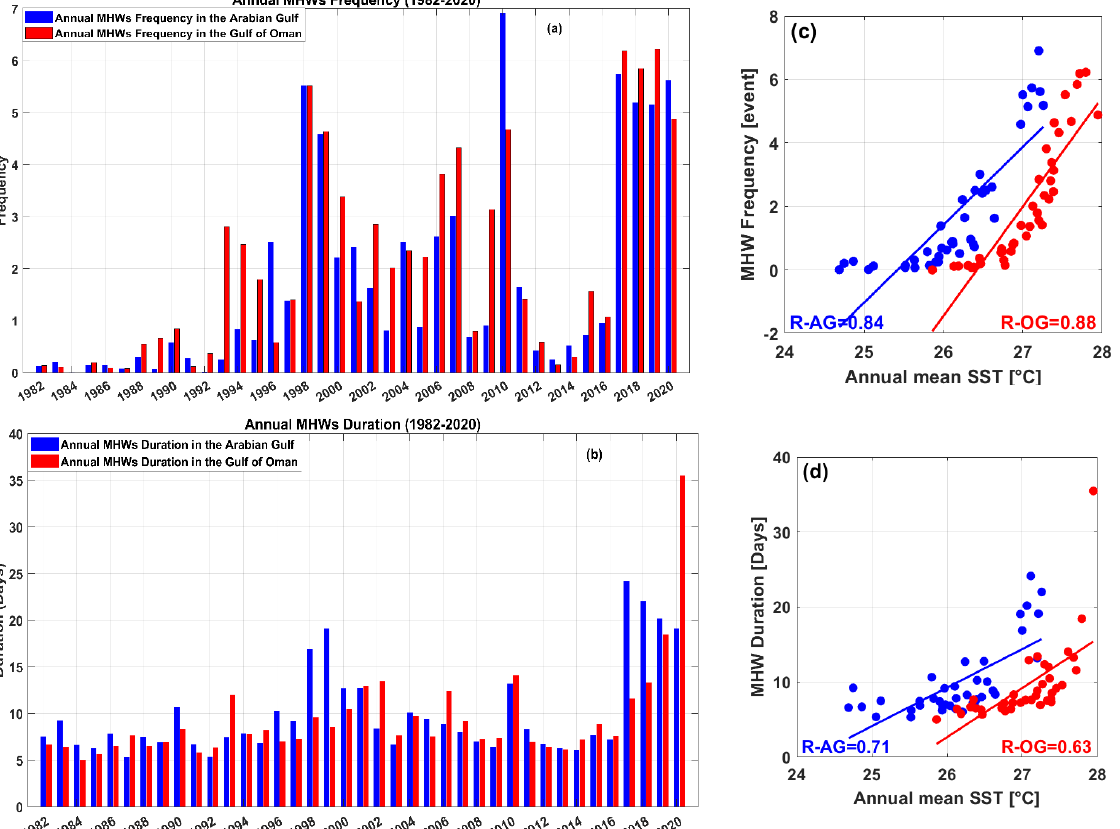
Figure 4. Regionally averaged annual means of the MHW ( a ) frequency (events/year), and ( b ) Duration (days/year). The blue and red bars represent the Arabian and Oman Gulfs (AG and OG), respectively. The right panels show the scatter plots of annual mean SST versus annual mean MHW ( c ) frequency, and ( d ) duration over the AG (blue) and OG (red) from 1982 to 2020, with the blue and red lines representing the best-fit linear curve.